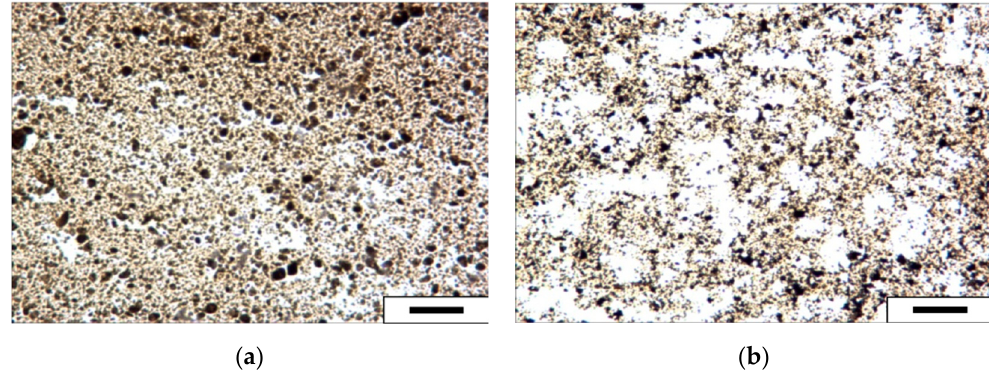
Figure 6. Optical microscopy images of a 1 wt.% asphaltene xylene system without SDY-1 ( a ) and with 0.1 wt.% SDY-1 ( b ). The scale bar is 5 μ m.